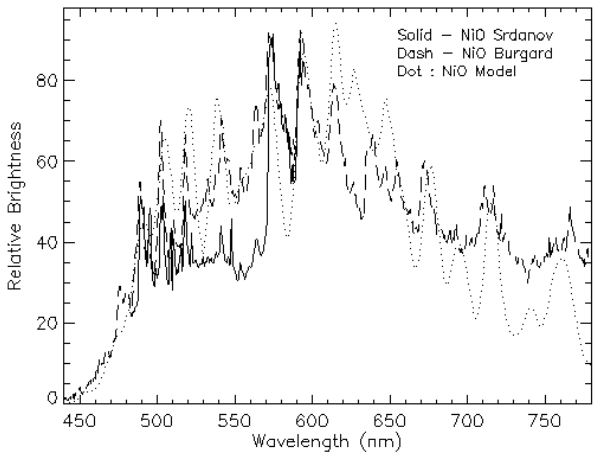
Fig. 1. A comparison of two laboratory spectra of chemilumines- cent NiO ∗ together with a preliminary spectral model simulation. The resolution of the Burgard spectrum in the visible region is ap- proximately 5nm.